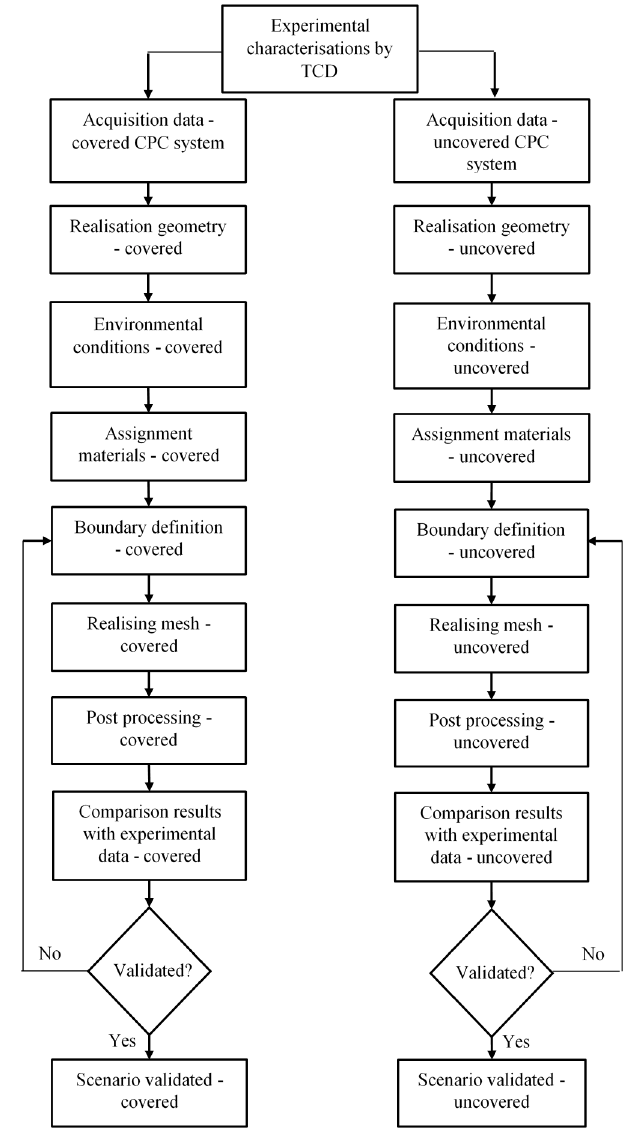
Figure 4. Flow chart of simulation campaigns.